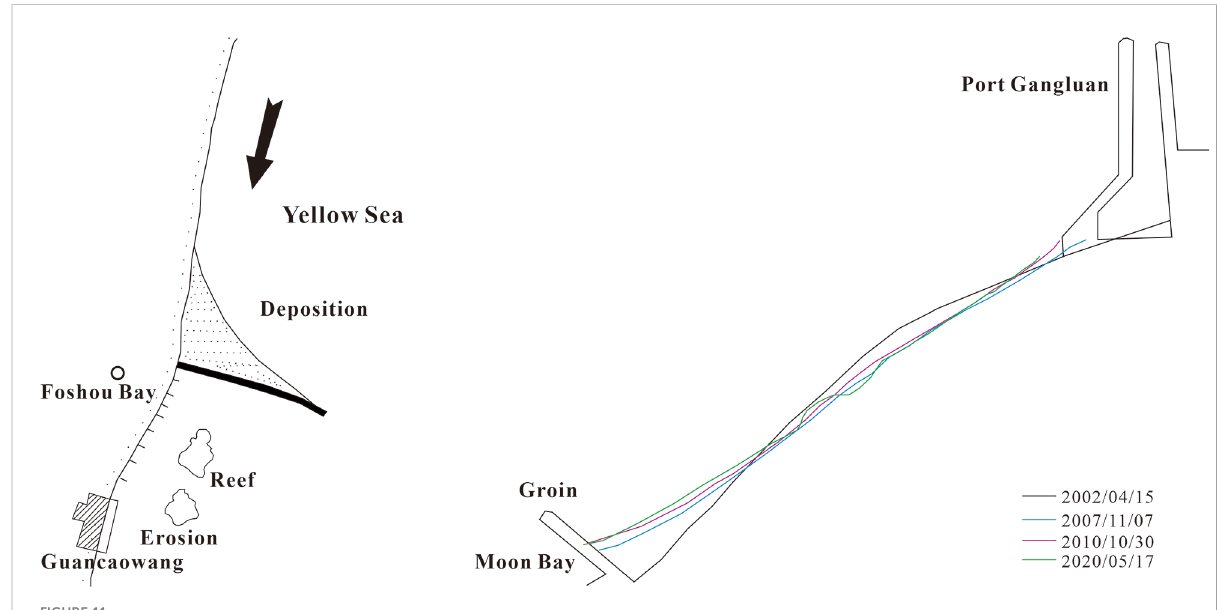
FIGURE 11 Effects of human activities on shoreline